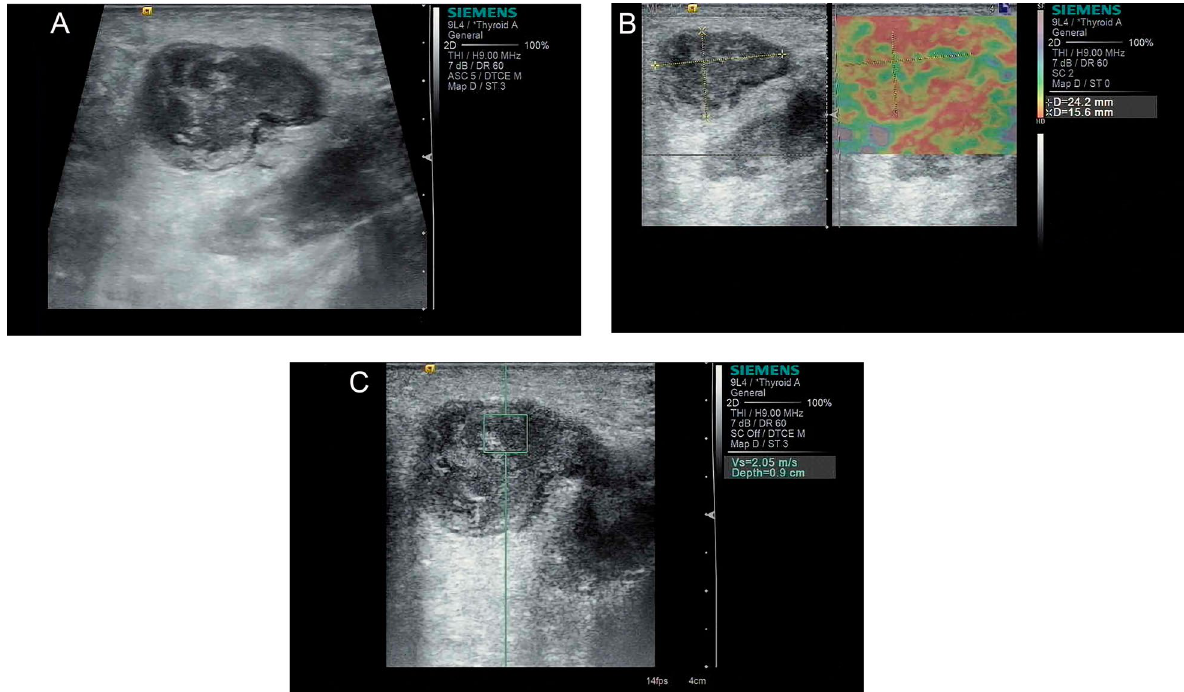
Fig. 3 Tuberculous LN correctly diagnosed by SE and ARFI as being benign. A Grayscale US image of cervical LN showing heterogeneous texture, long/short axis < 2 and lost hilum. B SE image total red area 10–50% consistent with elasticity scale 2. C ARFI showed SWV of 2.05